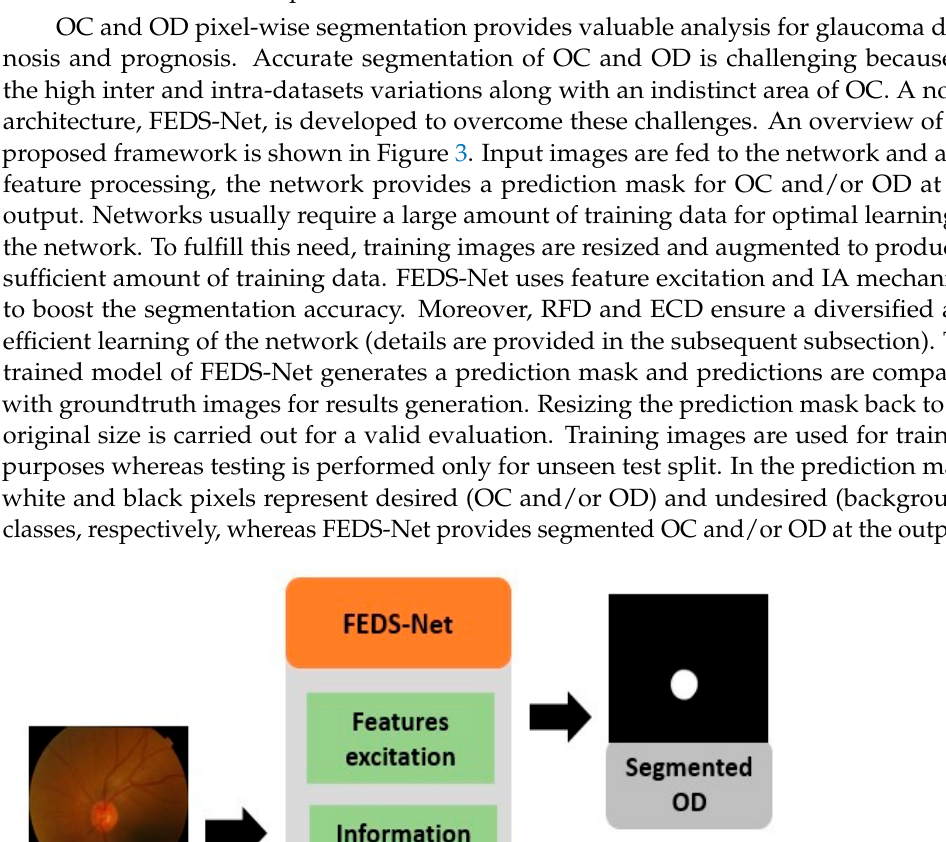
( c ) Figure 2. Sample images from row 1: Rim-One-r3; row 2: Drishti-GS databases. ( a ) Original image ( b ) groundtruth image with OD annotation ( c ) groundtruth image with the OC annotation. 3.2. Proposed Method